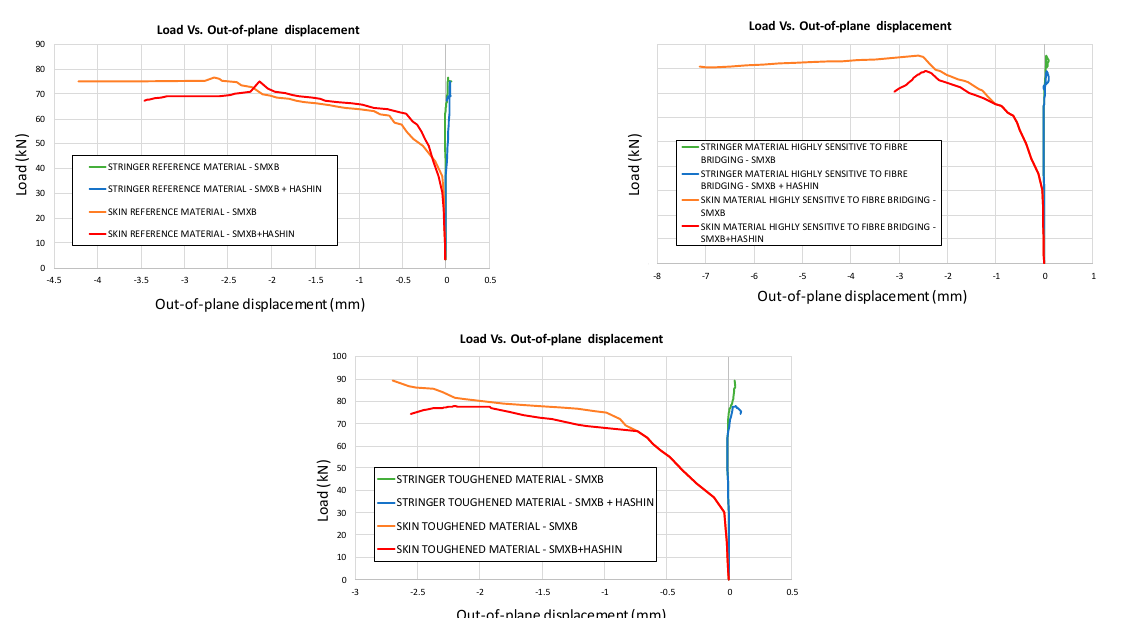
Figure 13. Load vs. Out-of-plane displacement comparison.